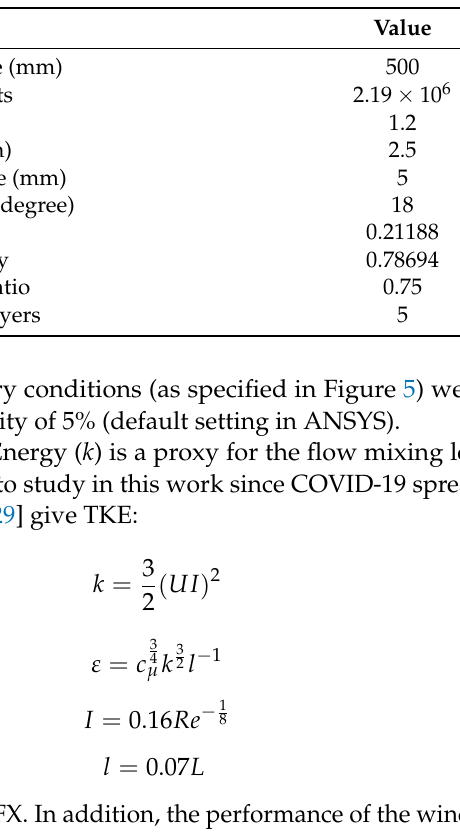
Table 1. Mesh properties.